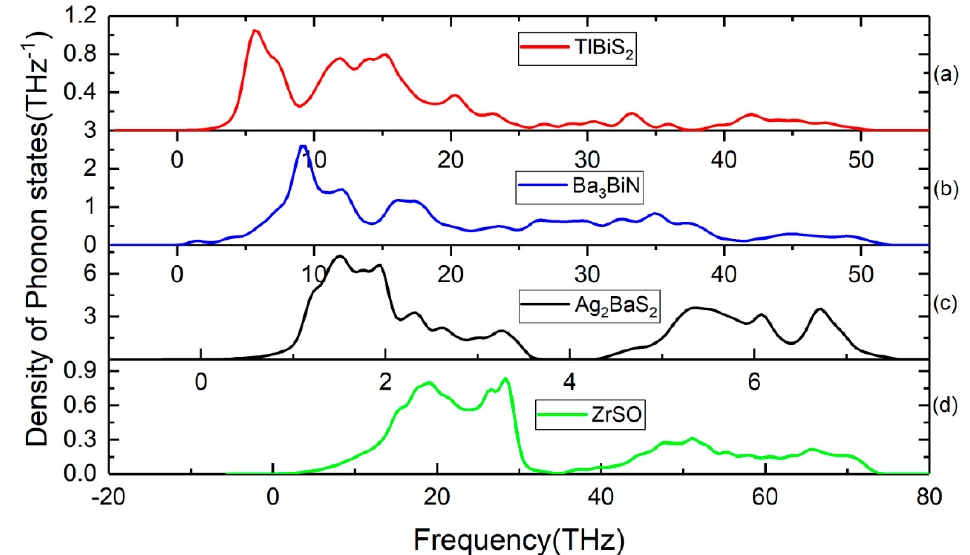
Figure 4. Calculated total phonon density of states for ( a ) TlBiS 2 , ( b ) Ba 3 BiN, ( c ) Ag 2 BaS 2 , and ( d ) ZrSO phases.